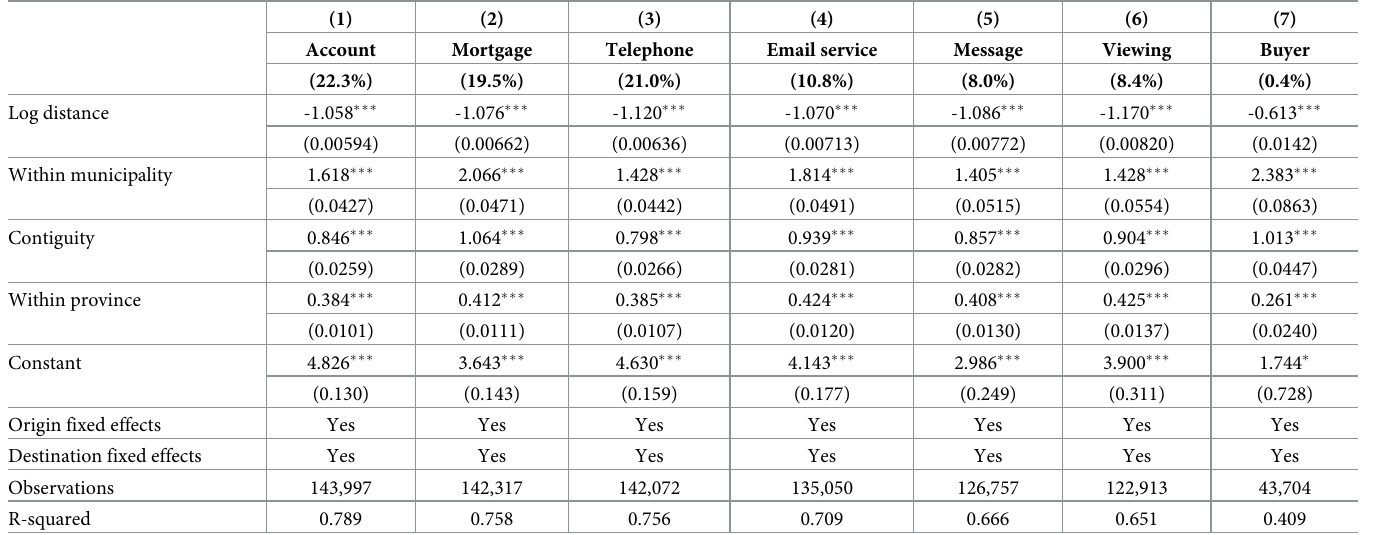
Table 3. Ordinary least squares estimates for serious